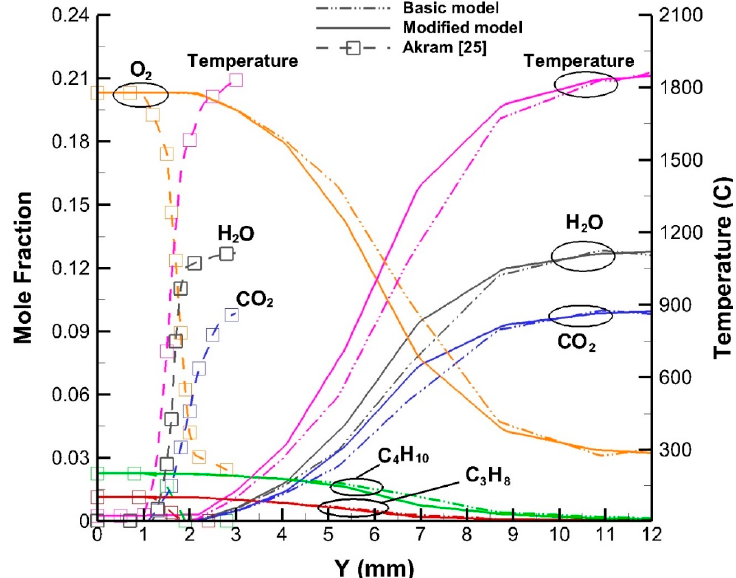
Figure 13. The species mole fraction and temperature variations of the stoichiometric LPG/air mixture for the basic model, modified model, and Akram’s results [25].